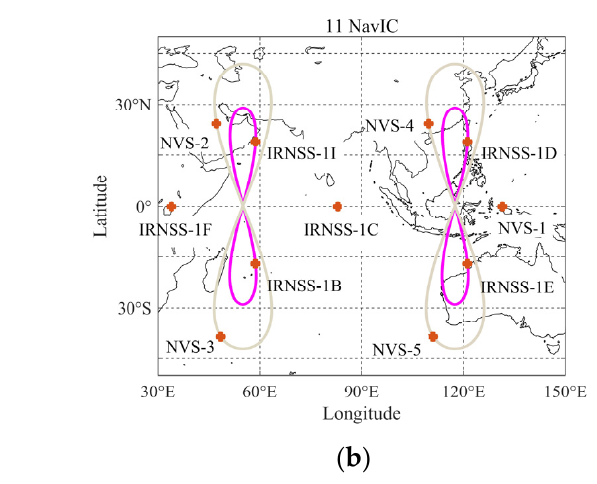
Figure 11. ( a ) ground tracks of 7-QZSS; ( b ) ground tracks of 11-NavIC.